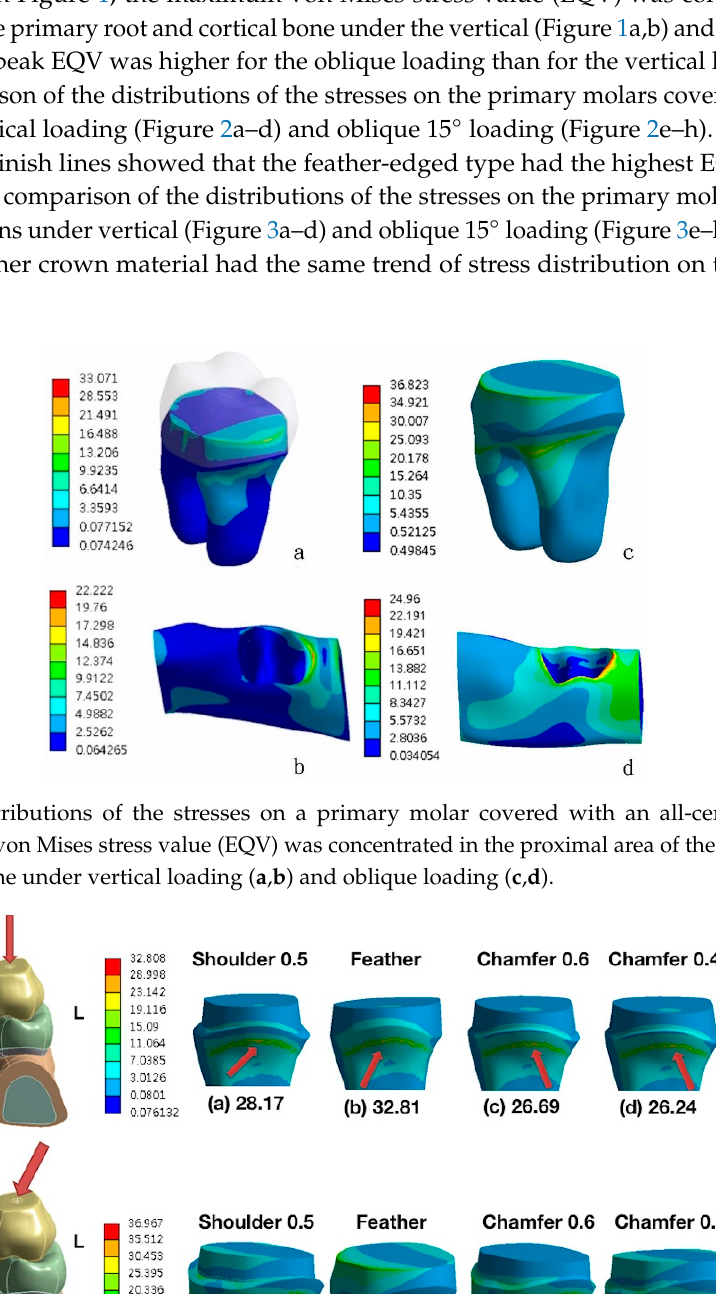
Figure 2. Distributions of the stresses on primary molars covered with zirconia crowns. (Top) A vertical load of 200 N applied to the lower, primary second molars. From left to right, the loading models are as follows: ( a ) shoulder (0.5 mm), ( b ) feather-edged, ( c ) chamfer (0.6 mm), and ( d ) mini chamfer (0.4 mm). (Bottom) The oblique 15° load of 200 N applied to the lower, primary second molars. From left to right, the loading models are as follows: ( e ) shoulder (0.5 mm), ( f ) feather-edged, ( g ) chamfer (0.6 mm), and ( h ) mini chamfer (0.4 mm). Red arrows indicate the peak stresses and locations. B—buccal; L—lingual.